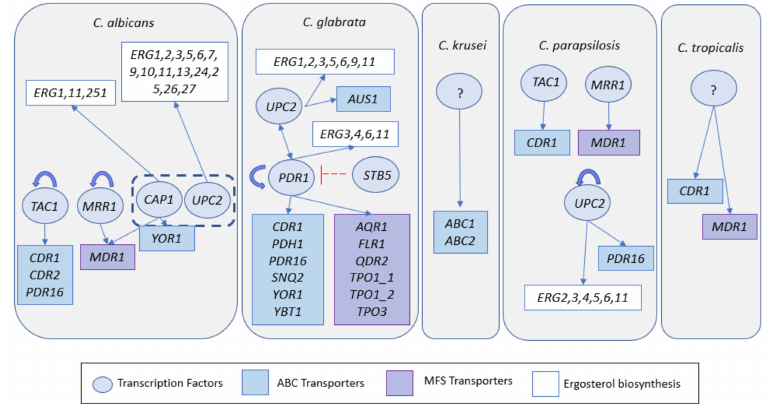
Figure 3. Schematic representation of regulatory associations between regulators involved in azole resistance and genes encoding multidrug resistance e ffl ux pumps demonstrated to be involved in azole resistance in Candida spp. The information concerning the regulatory associations between transcription factor and target genes was retrieved from the PathoYeastract database [84]. Although ABC-MDR and MFS-MDR transporters involved in azole resistance in C. krusei and C. tropicalis had been identified, until so far the regulators of these genes remain to be